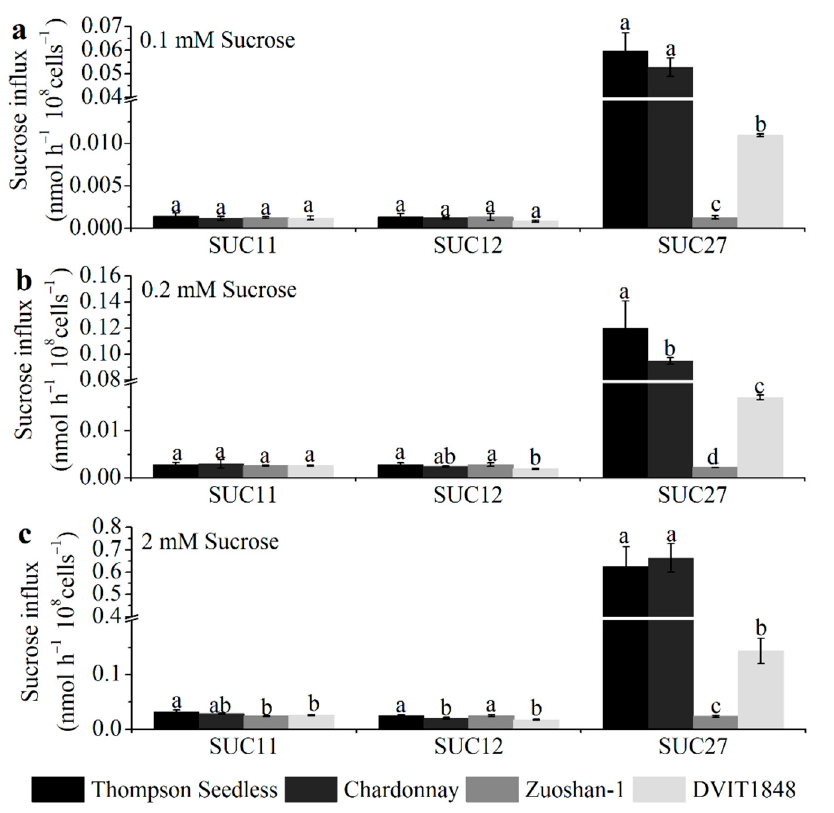
Figure 2. The sucrose transport ability of each SUT from Thompson Seedless, Chardonnay, Zuoshan- 1, and DVIT1848, respectively. The sucrose transport ability was tested under 0.1 ( a ), 0.2 ( b ), and 2 mM ( c ) sucrose concentrations. The error bar indicated mean ± SD ( n = 3). Different lowercase letters showed statistically significant differences among different